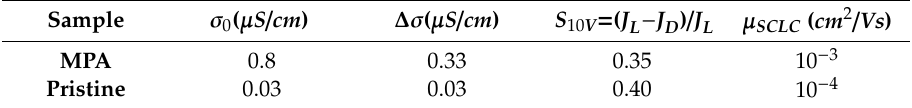
Table 2. Dark conductivity ( σ 0 ), photoconductivity ( ∆ σ ), photoconductive sensitivity (S), and Mott–Gurney mobility ( µ ), extracted with Equation (8), of MSM photodetectors based on CsPbBr 3 PNCs. The pristine and MPA-treated thin films parameters were extracted from J – V curves in Figure